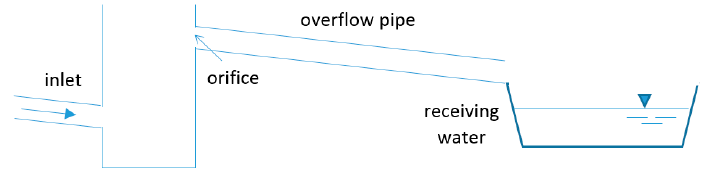
Figure 2. Sketch of the overflow structure studied by Isenmann et al. [35] (redrawn).